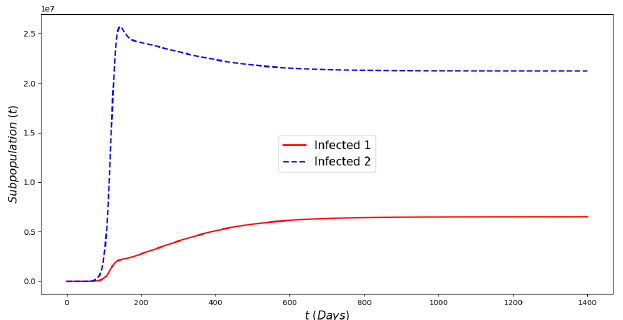
≈ 1.5 > R ≈ 1.4. The 0 1 2